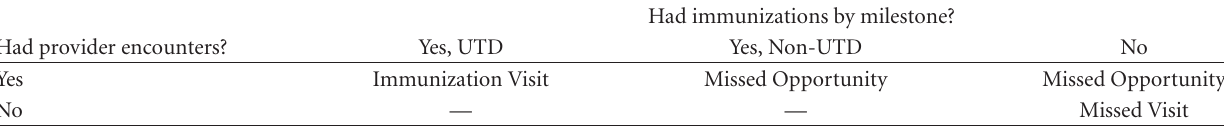
Figure 1: Children by Count of Milestones with All Age-Appropriate Immunizations. Table 1: Immunization Encounter Classification.